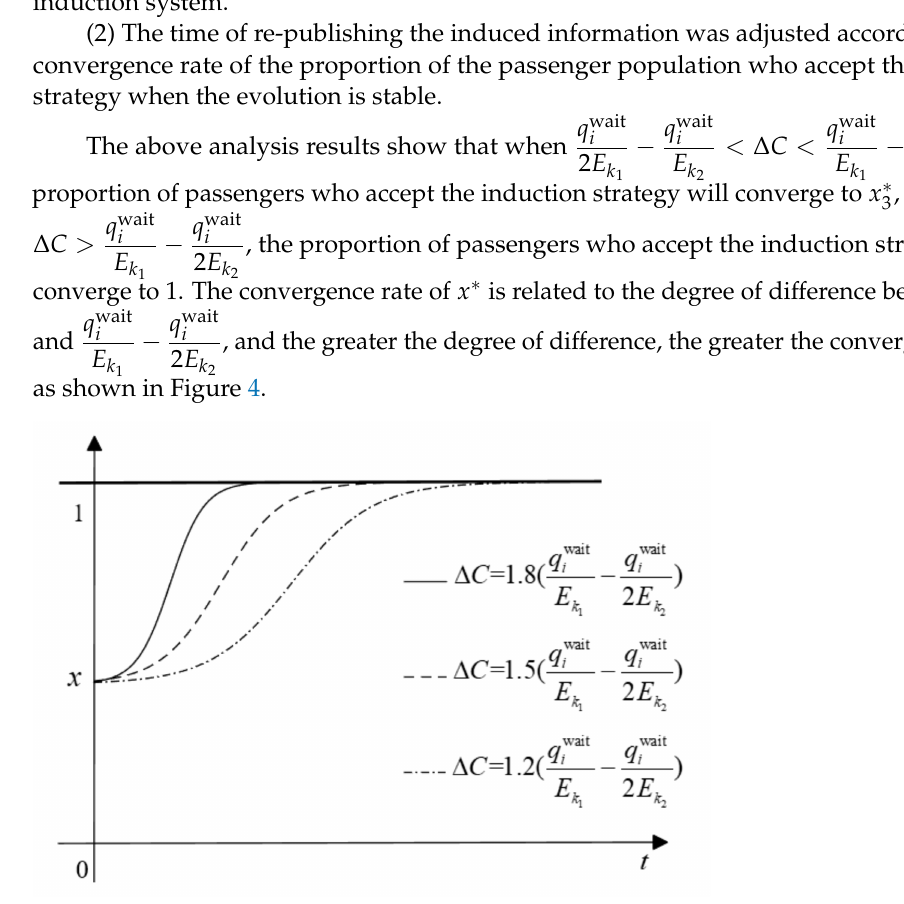
Figure 4. The rate of convergence of x ∗